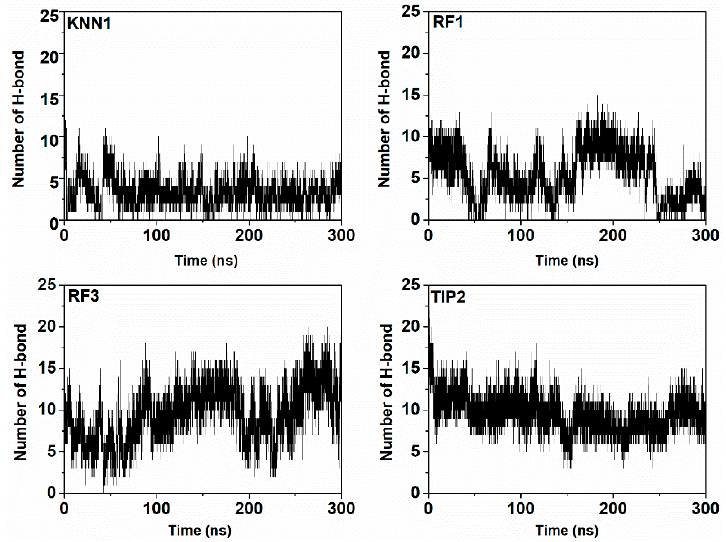
Figure 9. Number of hydrogen bonds plots of the tyrosinase-hdTIPs complexes during 300 ns of the molecular dynamic simulation